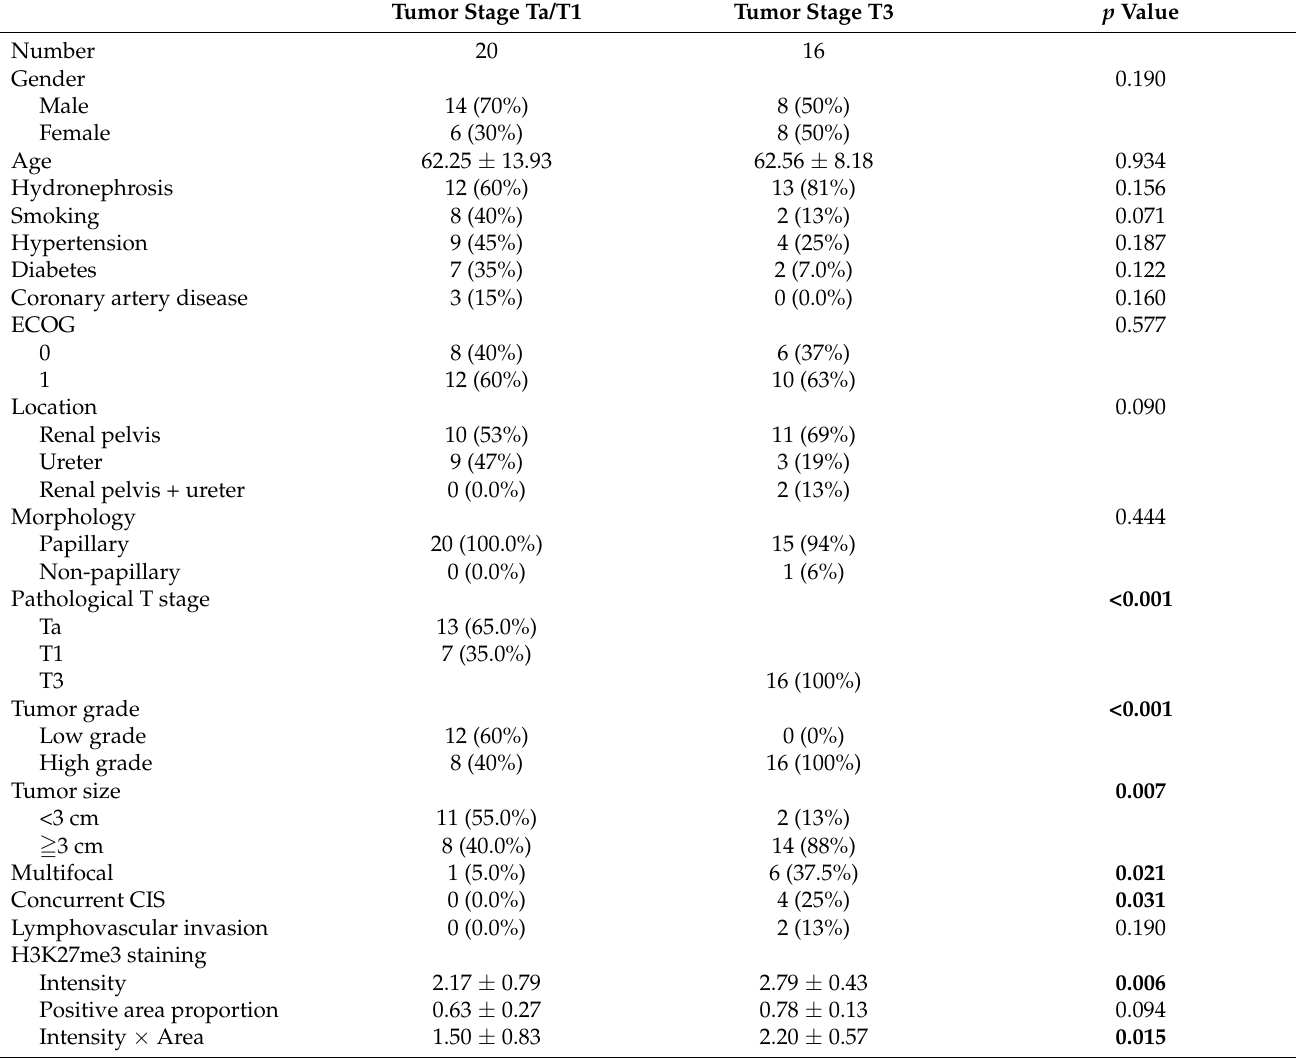
Table 1. Clinical, pathological and H3K27me3 staining value